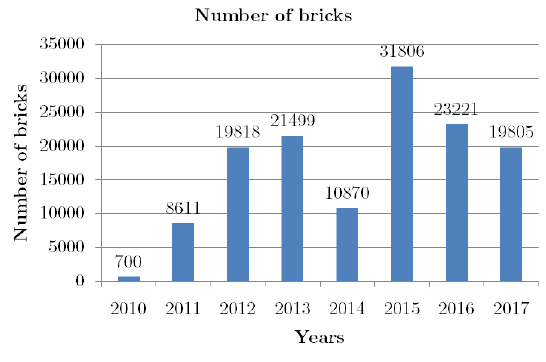
Figure 1. Sales of unfired bricks by HELUZ cihlářský průmysl v.o.s.